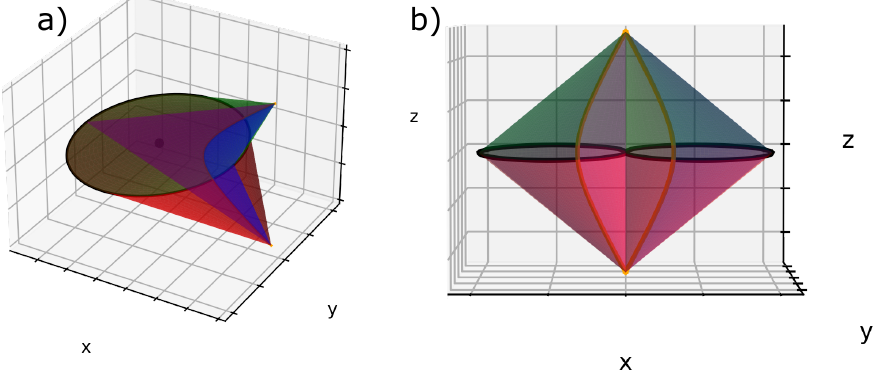
Figure 7. ( a ) FCD limited by four revolution cones: two of them lie on the ellipses and the two others lie on the hyperbolas; ( b ) two adjacent FCDs: their ellipses are tangent, and their confocal hyperbolas are merging at two poles. The two cones posses a common generatrix in agreement with the law of corresponding